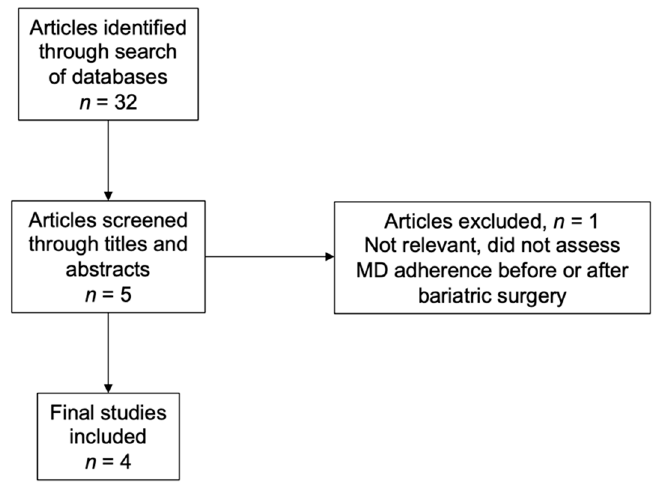
Figure 2. Selection Process for